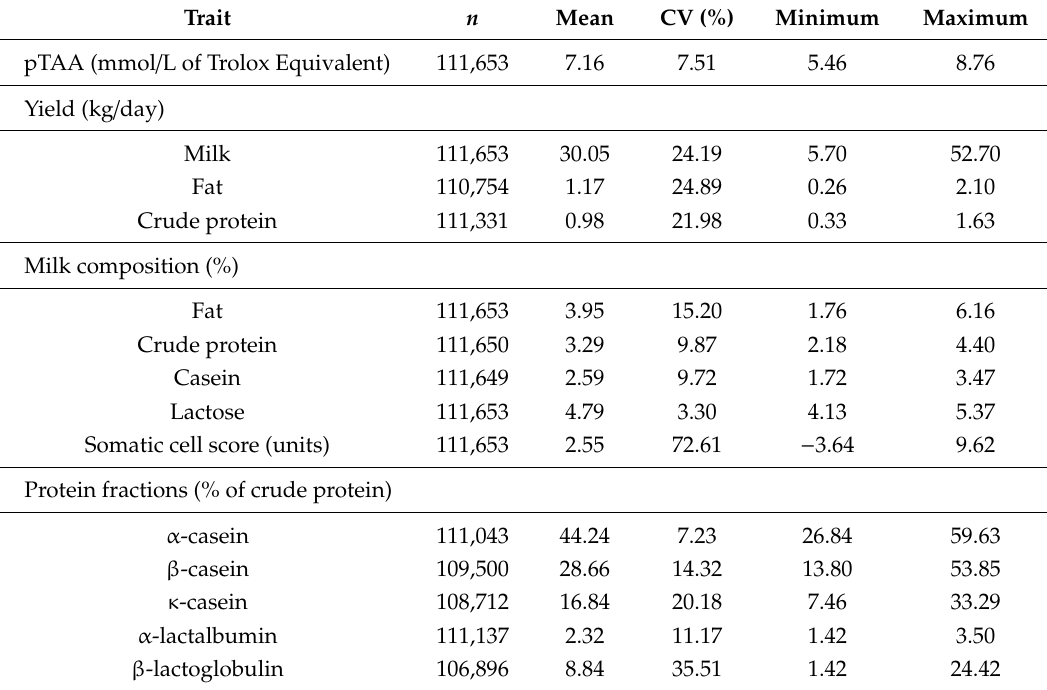
Table 1. Mean, coe ffi cient of variation (CV), minimum and maximum of bovine milk predicted total antioxidant activity (pTAA), yield and composition traits, somatic cell score, and protein fractions. Trait n Mean CV (%) Minimum Maximum pTAA (mmol / L of Trolox Equivalent) 111,653 7.16 Yield (kg / day) Milk 111,653 Fat